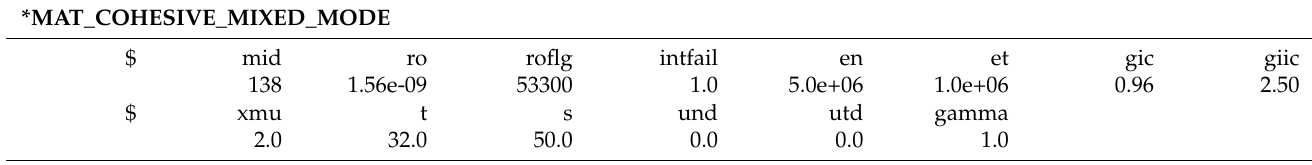
Table A4. Used LS-DYNA material card *MAT_138 for cohesive elements without interface modifica- tion ( κ = 1.0) in unit system